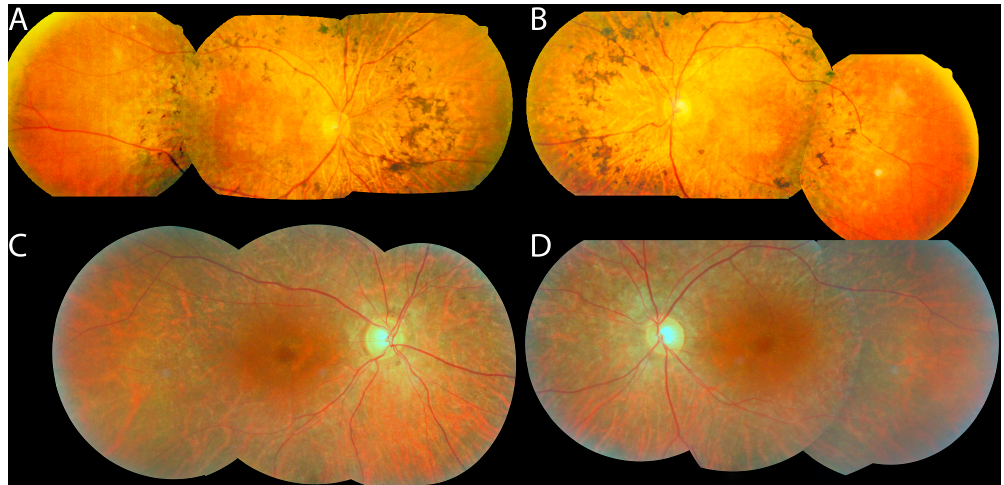
Figure 3. Fundus photos of patients with HGSNAT mutations: #34 ( A , B ) and #15 ( C , D ). Note that the bone spicules ( A , B ) or RPE depigmentation ( C , D ) are more posteriorly located than in typical RP, and that the fundus begins to show a more normal color peripherally (especially temporally in these photos).